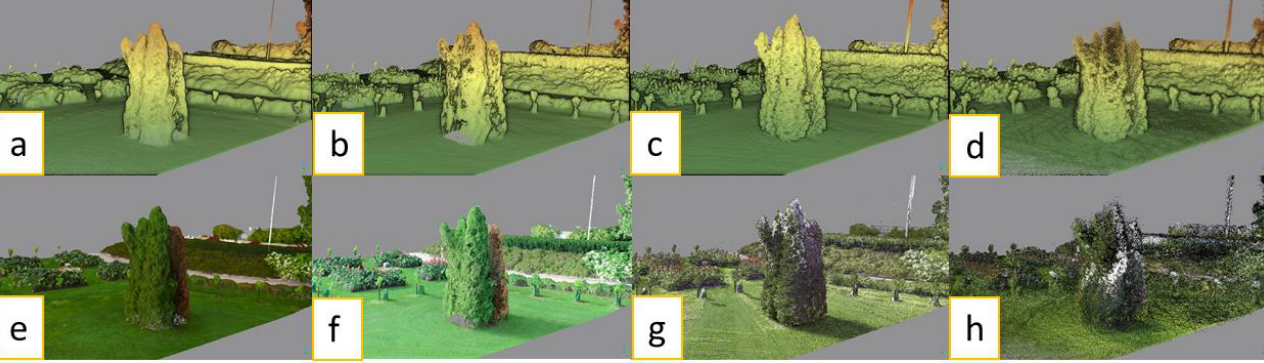
Figure 7. Comparisons of point clouds for small trees. In the top row, the point clouds are colored with the height ramp, and in the bottom row with RGB colorization.